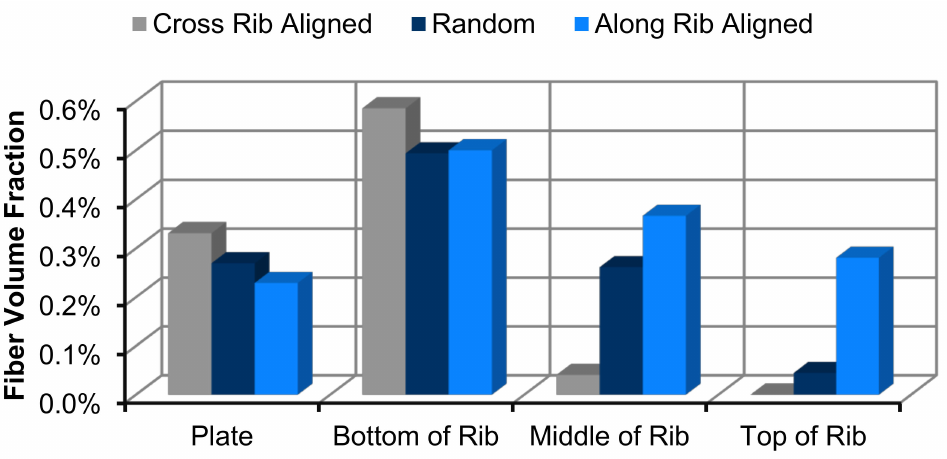
Figure 13. Fiber volume fraction throughout the rib for different initial fiber orientations. All simulations used a center charge with 20 mm fibers and a rib entrance radius of 5